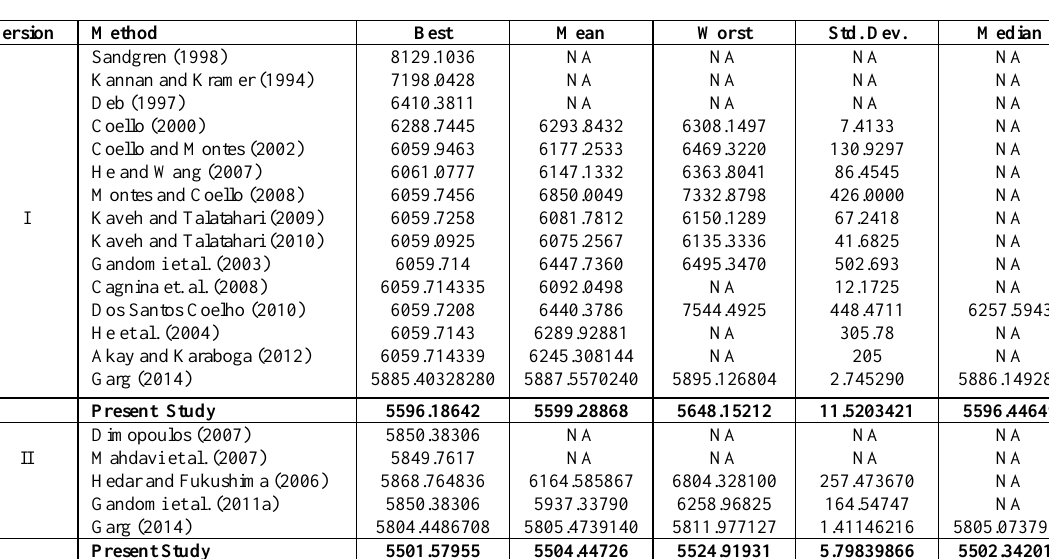
Table 2. Statistical results of different methods for pressure vessel